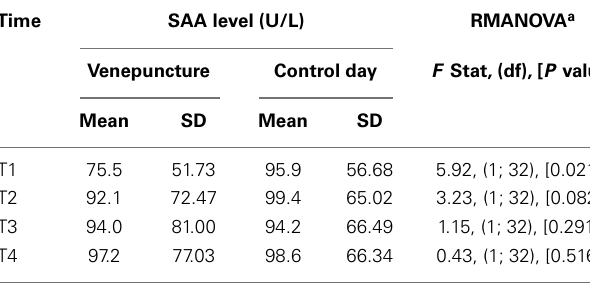
Table 4 | Comparison of pattern of salivary α -amylase (SAA) of 33 workers on venepuncture and control days